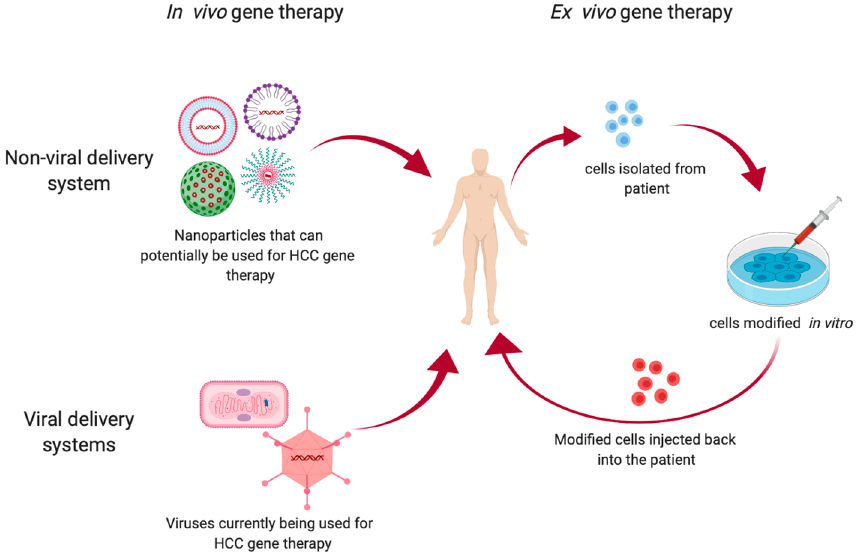
Figure 1. An overview of the types of gene therapy techniques used in HCC treatment.